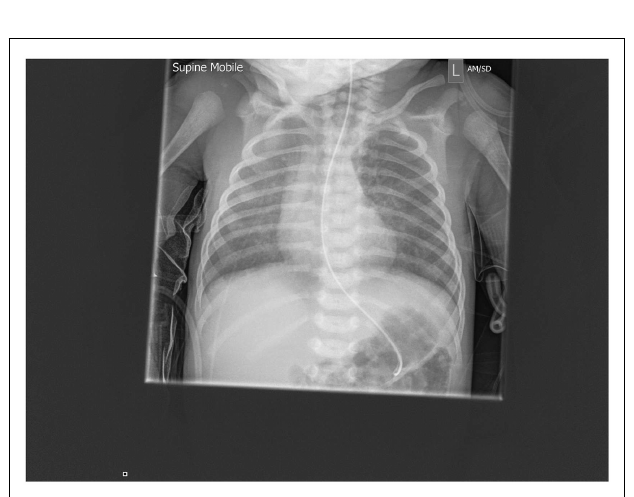
FIGURE 3 | Post-aspiration chest x-ray showing well-defined radio-dense opacities through all zones of the right lung and similar but less extensive changes on the right .